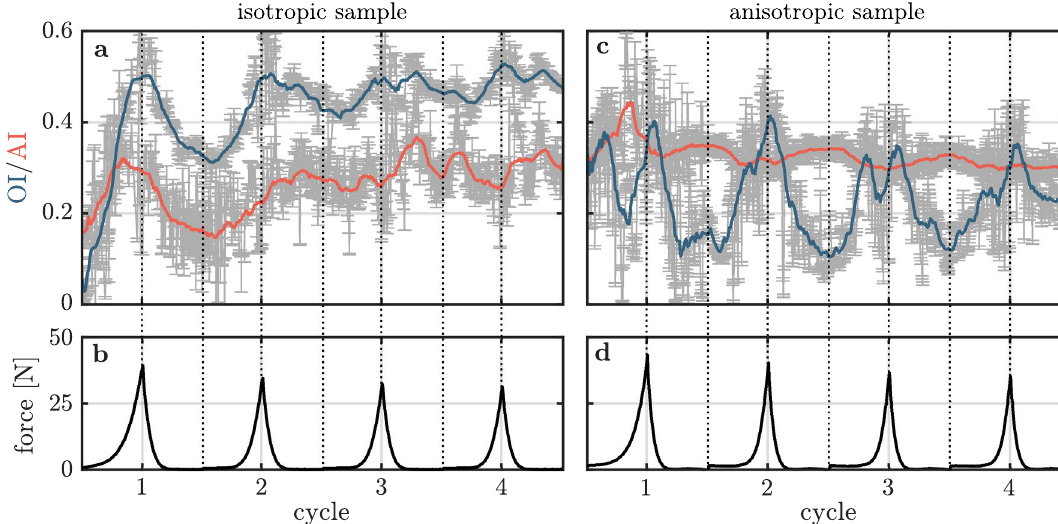
Figure 3. Derived parameters of the FINE algorithm applied to the collagen fiber network of the isotropic and the anisotropic sample under repeated stretching and relaxation. ( a ) Orientation index (OI) and alignment index (AI) of the collagen network of the isotropic sample as a function of the deformation cycle number. Data points with error bars indicating the 95% confidence intervals are shown in grey. Solid lines represent smoothed data points. ( b ) Averaged force acting on the isotropic sample measured by the force sensors as a function of the deformation cycle number. ( c ) OI and AI of the collagen network of the anisotropic sample as a function of the deformation cycle number. ( d ) Averaged force acting on the anisotropic sample measured by the force sensors as a function of the deformation cycle